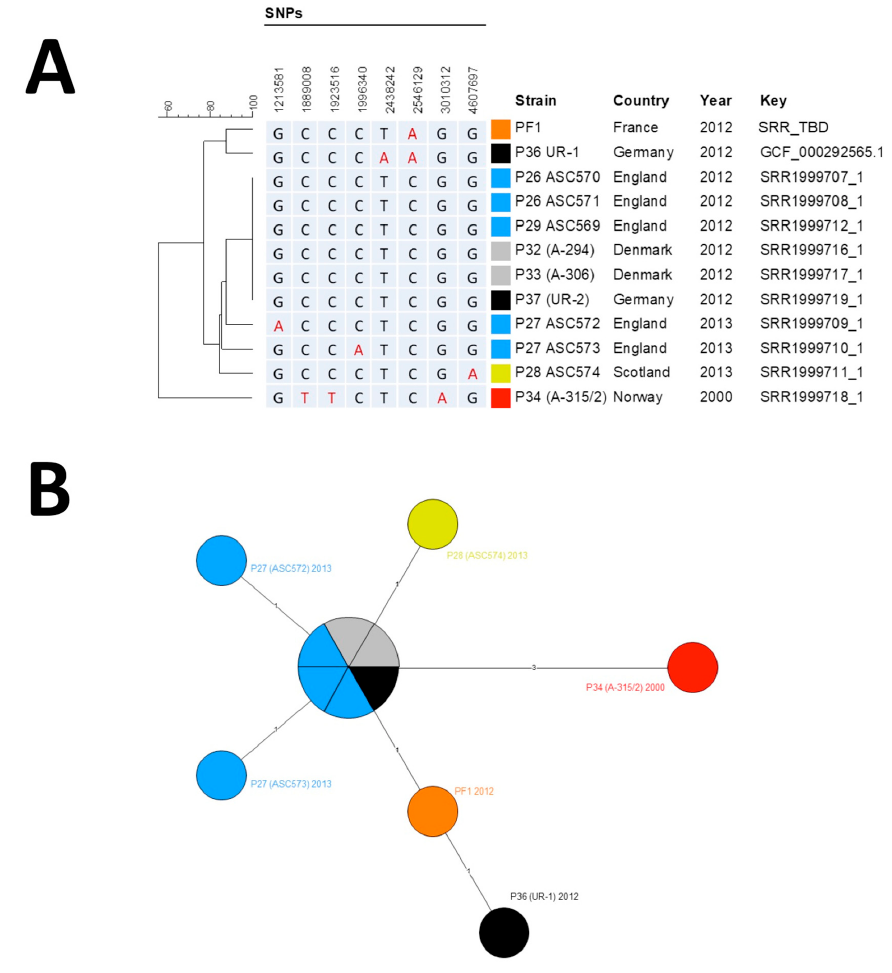
Figure 2. Phylogenetic analysis of B. anthracis strains. ( A ) Phylogenic tree of single-nucleotide polymorphism (SNP) profiles found among Group II strains. Position is calculated from Ames Ancestor Reference Genome. ( B ) Minimum spanning tree based on SNP profiles among Group II strains. (A-B) The different strains groups are color-coded by their geographical origin: red, original Norwegian strain; orange, French strain described here; light blue, English strains; yellow, Scottish strain; black, German strains; gray; Danish strains.